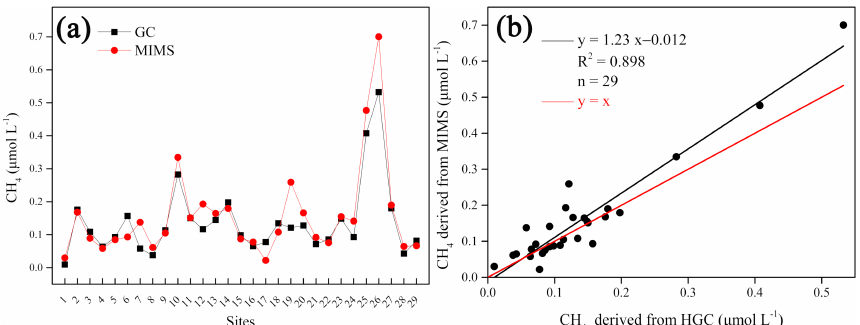
Figure 5. Relationship between the CH 4 concentrations derived from MIMS and CH 4 concentrations based on GC. ( a ) represents the differences between GC and MIMS, ( b ) is the fitting curve between GC and MIMS.